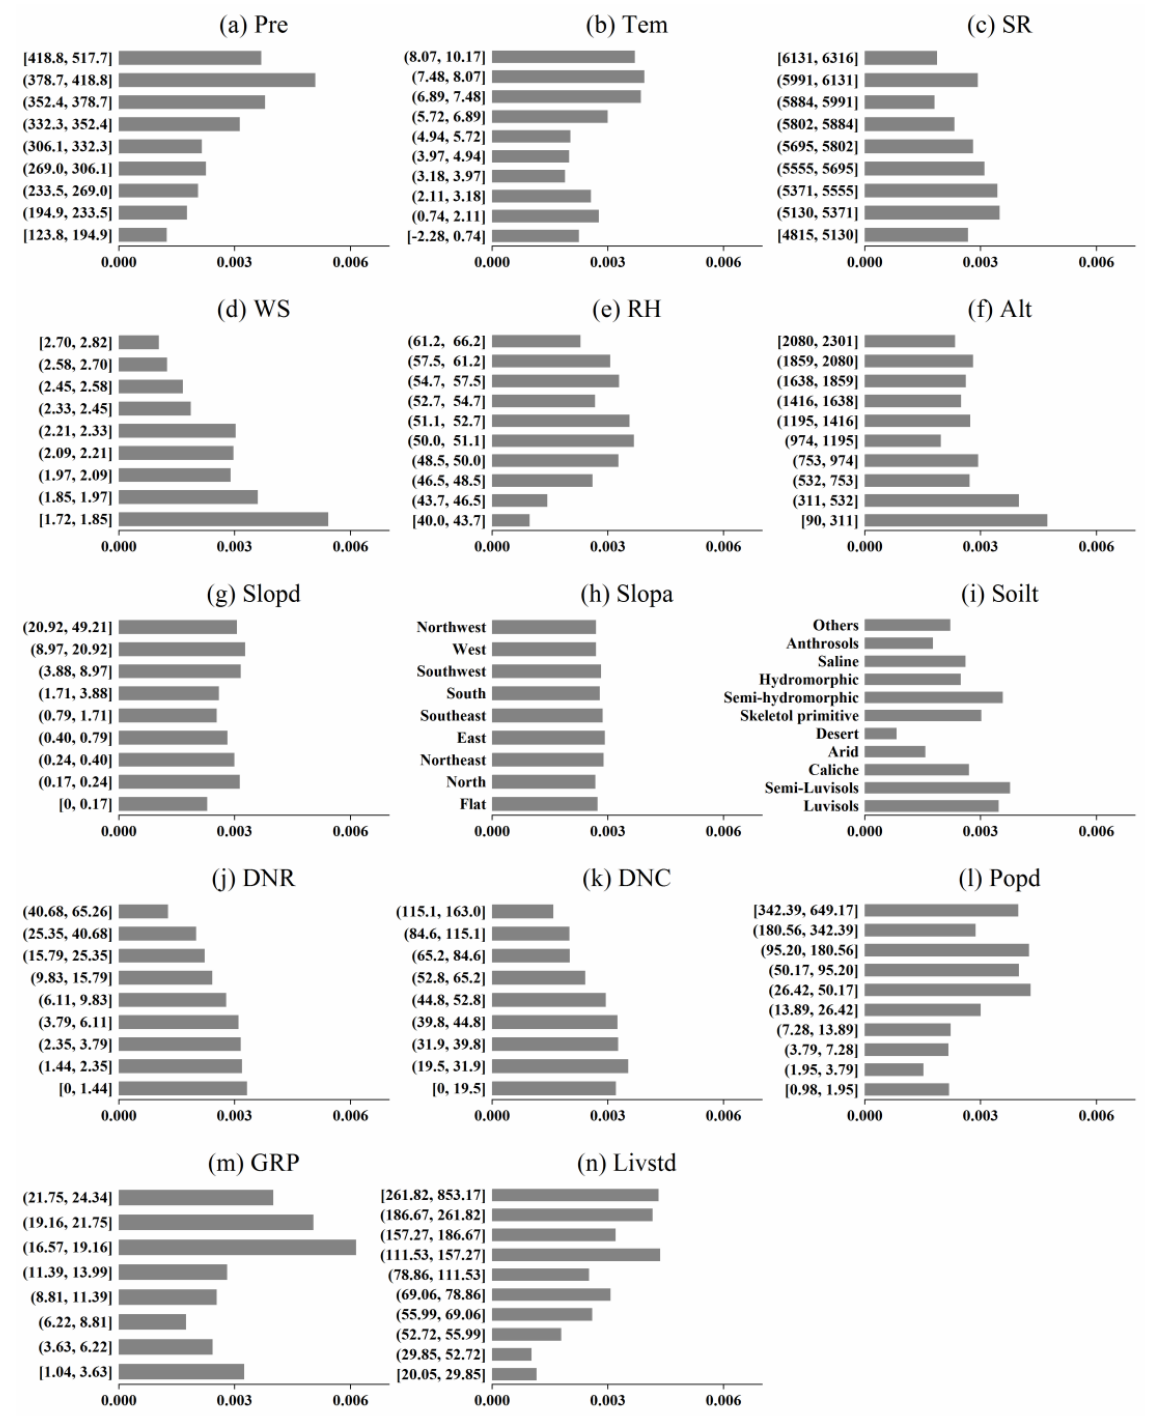
Figure 9. Influences of the factors’ different grades on the magnitude of the increase in the NDVI. The units of Pre (precipitation), Tem (air temperature), SR (solar radiation), WS (wind speed), RH (relative air humidity), Alt (altitude), Slopd (slope), Slopa (slope aspect), DNR (distance to the nearest road), DNC (distance to the nearest county center), Popd (population density), GRP (per capita gross regional product), and Livstd (livestock density) are mm, ◦ C, MJ · m − 2 , m · s − 1 , %, m, ◦ , ◦ , km, km, person · km − 2 , 10,000 yuan person − 1 , and sheep · km − 2 , respectively. Soilt represents the soil type.